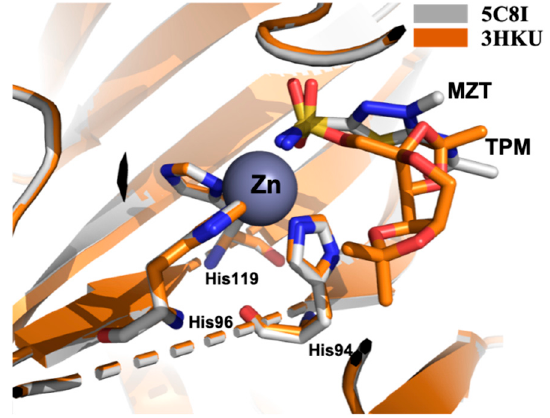
Figure 6. Superposition between CAII in complex with MZT (grey) and TPM (orange).